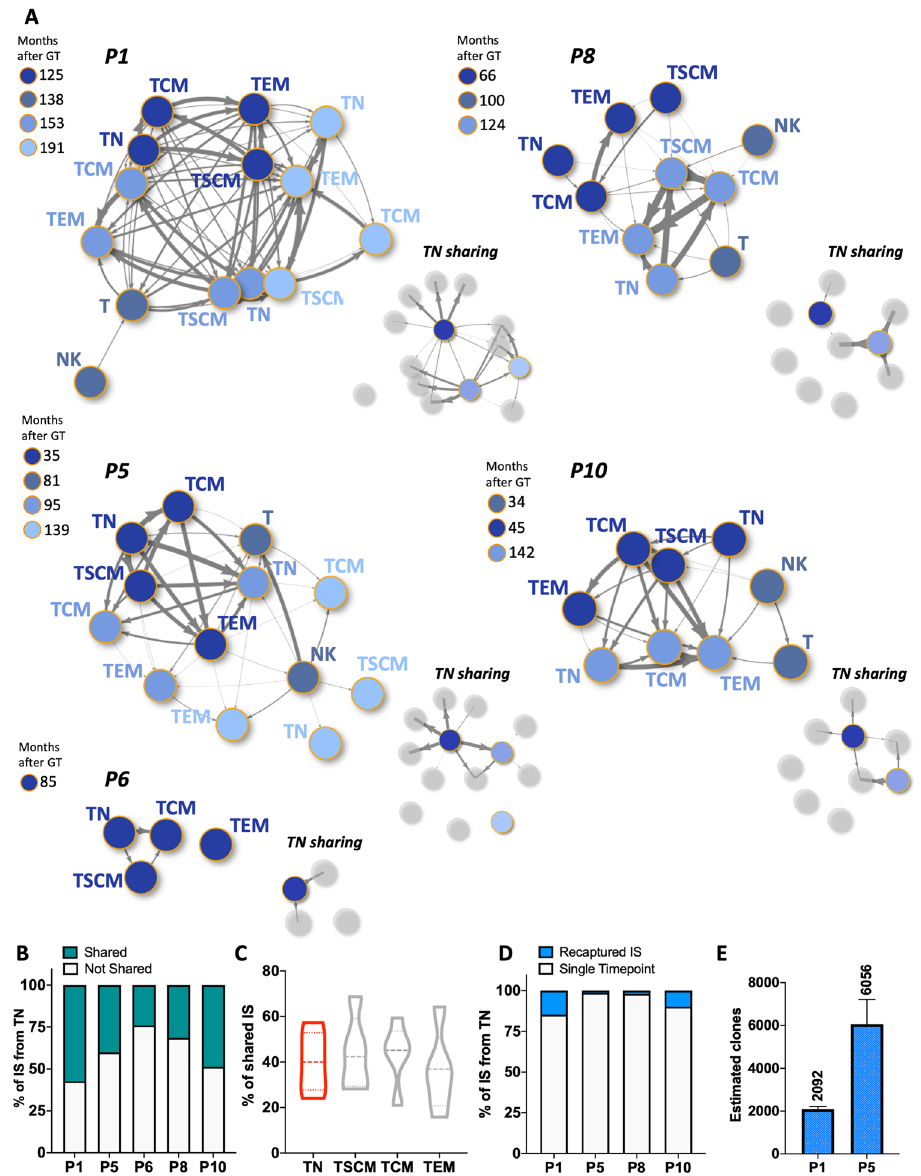
Fig. 5 Sharing and recapture of integrations sites across T-cell subpopulations and timepoints. A Network plots showing signi fi cant sharing of IS among the T-cell subtypes and NK cells (data described in Fig. 5) from each patient. Each node represents a sample and it is coloured according to the timepoint after GT. The thickness of the arrows is proportional to the value of positive Pearson correlation coef fi cients calculated on the basis of IS sharing between pairs of samples (ranges of values are displayed on the heatmaps of Supplementary Fig. 14). For each patient two plots are shown: the networks on the left display positive correlations among all samples while the network on the right (TN sharing) highlights correlations between TN cells (nodes in scale of blue) and the rest of the subtypes (nodes in grey). B Stacked bars showing in green the fraction (%) of IS from TN of all timepoints for each patient which were shared with at least another T cell subtype. C Violin plots showing the percentage of IS belonging to each T subpopulation shared with at least another T cell subtype (data from all patients and timepoint; TN data highlighted in red). D Stacked bars showing in blue the fraction of IS re-captured across multiple timepoints within the TN populations of each patient (a more detailed view of re-captured IS from TN is displayed on the heatmaps of Supplementary Fig. 15). E Clonal abundance (number of clones in circulation) of long-term lymphoid progenitor estimated in P1 and P5 on the basis of size of IS datasets at each timepoint and re-capture probabilities overtime of IS within the TN compartment (values derived from the Mh Chao loglinear model for capture-recapture and relative standard errors as reported Supplementary Table